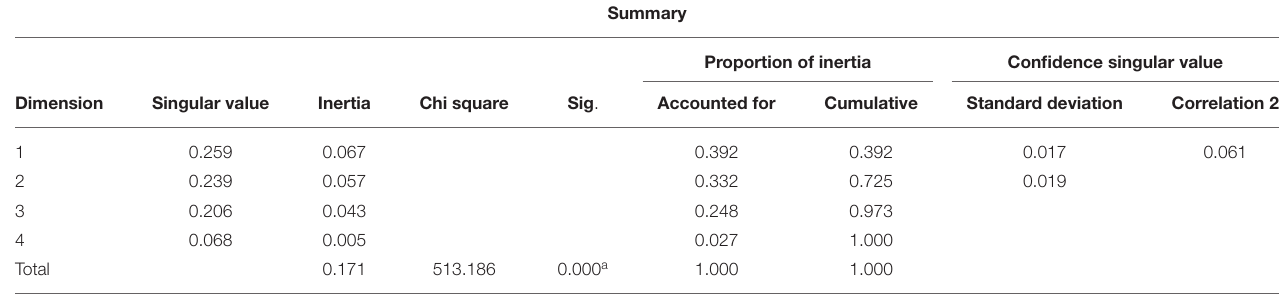
TABLE 9 | Summary table of the simple correspondence analysis.